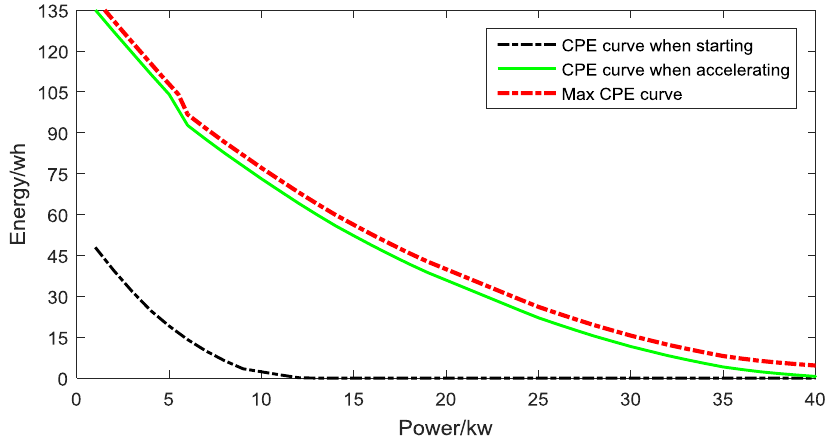
Figure 12. CPE curves in special phases.